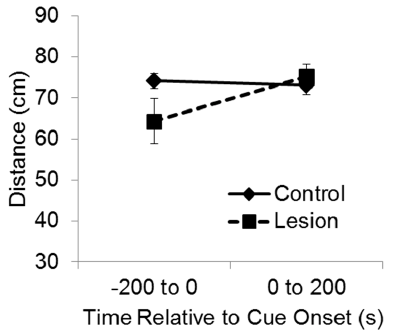
Figure 3. Hippocampus and recollection of cue location. The distance between the subjects and the corner of the platform nearest the active speaker is plotted during the test session. The lesioned subjects avoided the corner near the active speaker less than control subjects during baseline. After cue onset, the lesioned subjects moved away from the cue and avoided the corner near the active speaker the same as control subjects.